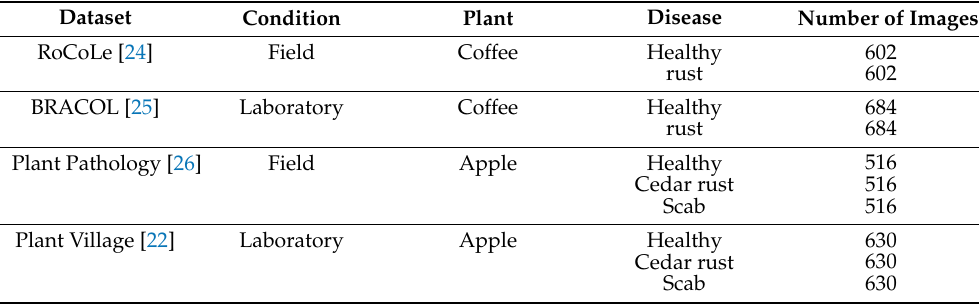
Table 2. Datasets details. The Table presents only the samples and the classes used to conducted the present case study as described in Section 2.2. For a detailed description of the entire dataset, the reader is referred to the relevant